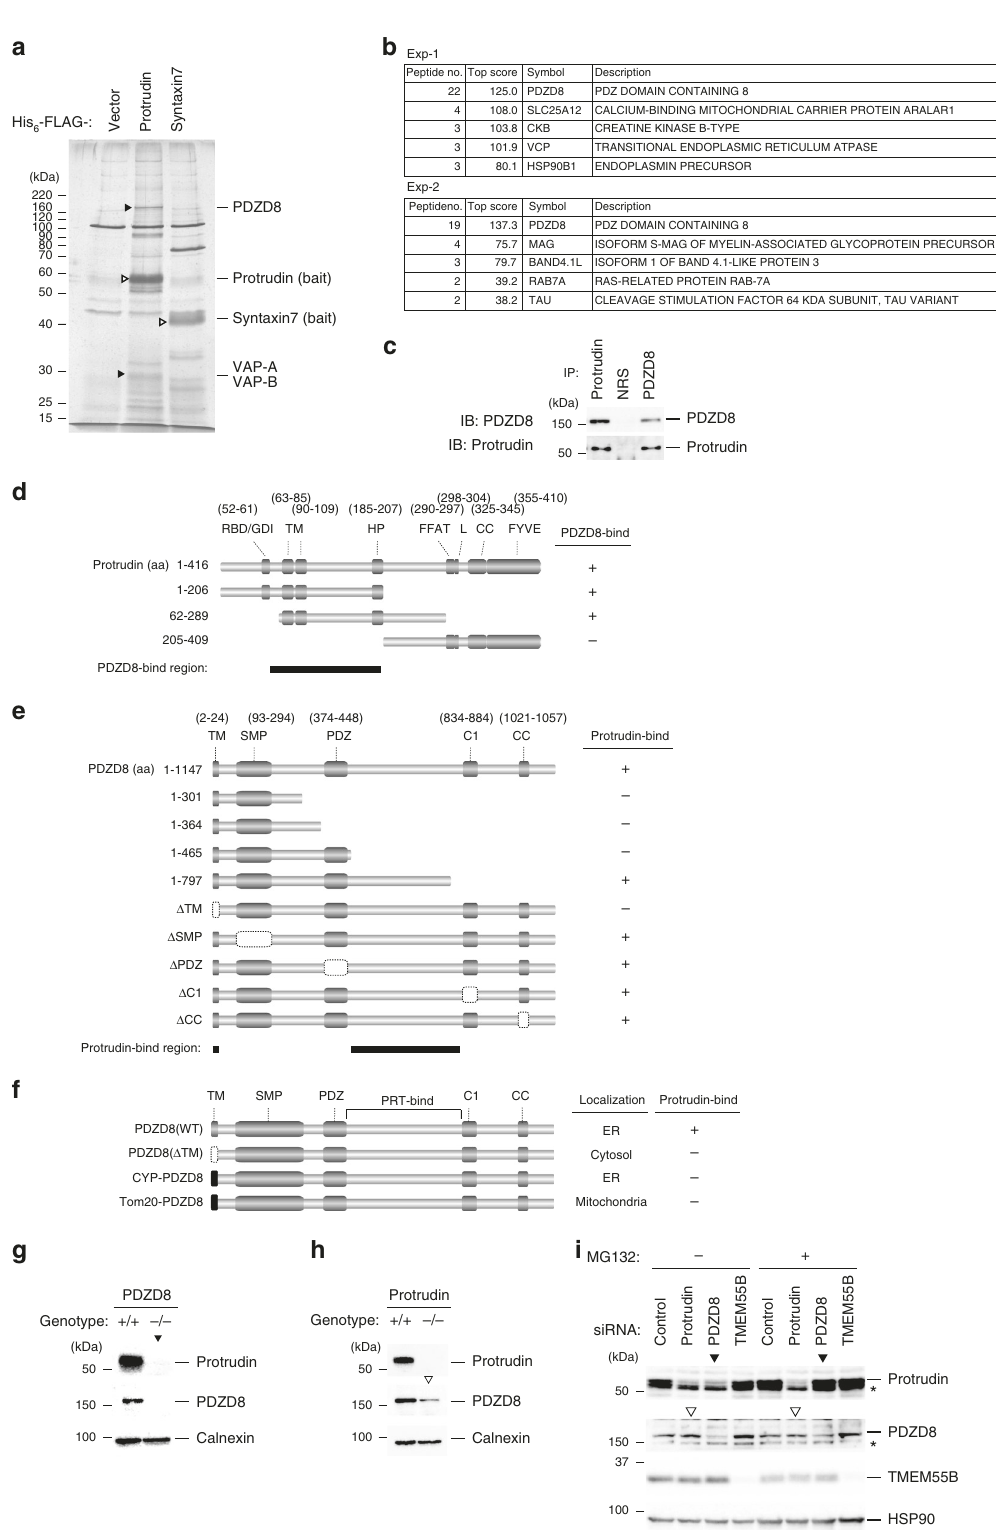
was unstable and subjected to proteasomal degradation in the absence of PDZD8. In contrast, the abundance of PDZD8 was not affected by depletion of protrudin in PC12 cells (Fig. 1i). Altogether, these results suggested that protrudin and PDZD8 might be cotranslated and form a stable complex at the ER membrane in the brain, whereas the individual proteins undergo rapid degradation by the proteasome when expressed alone.